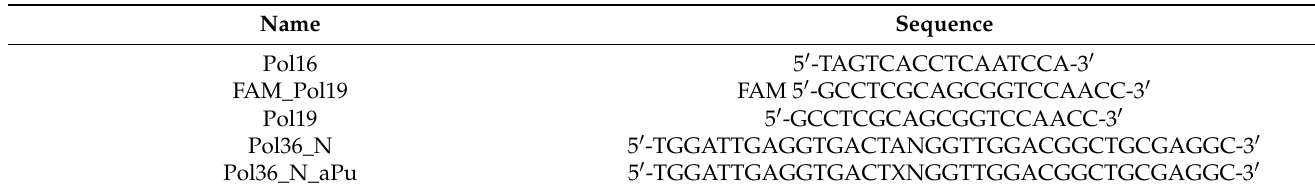
Table 6. Sequences of